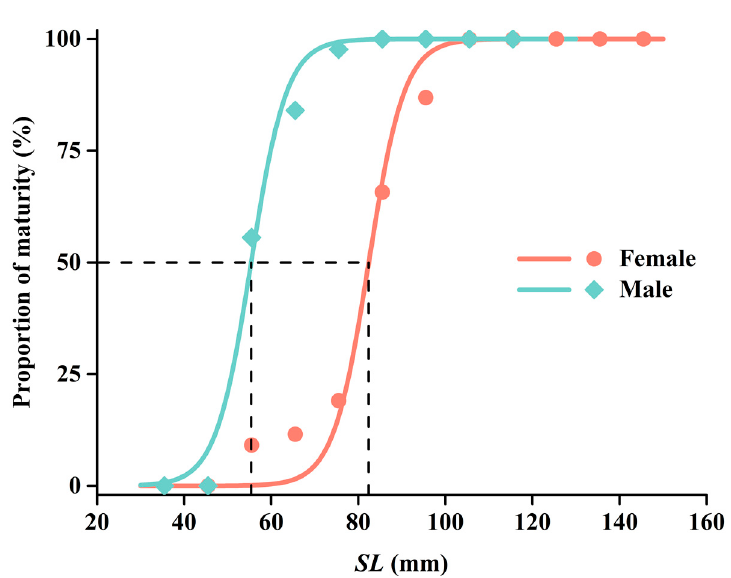
Figure 4. Logistic functions fitting to the proportion of mature individuals by 10 mm standard-length ( SL ) interval for both sexes of G. tibetana in the lower Yarlung Tsangpo River, dotted lines showing the estimated values of standard length at first maturity ( SL 50% ).